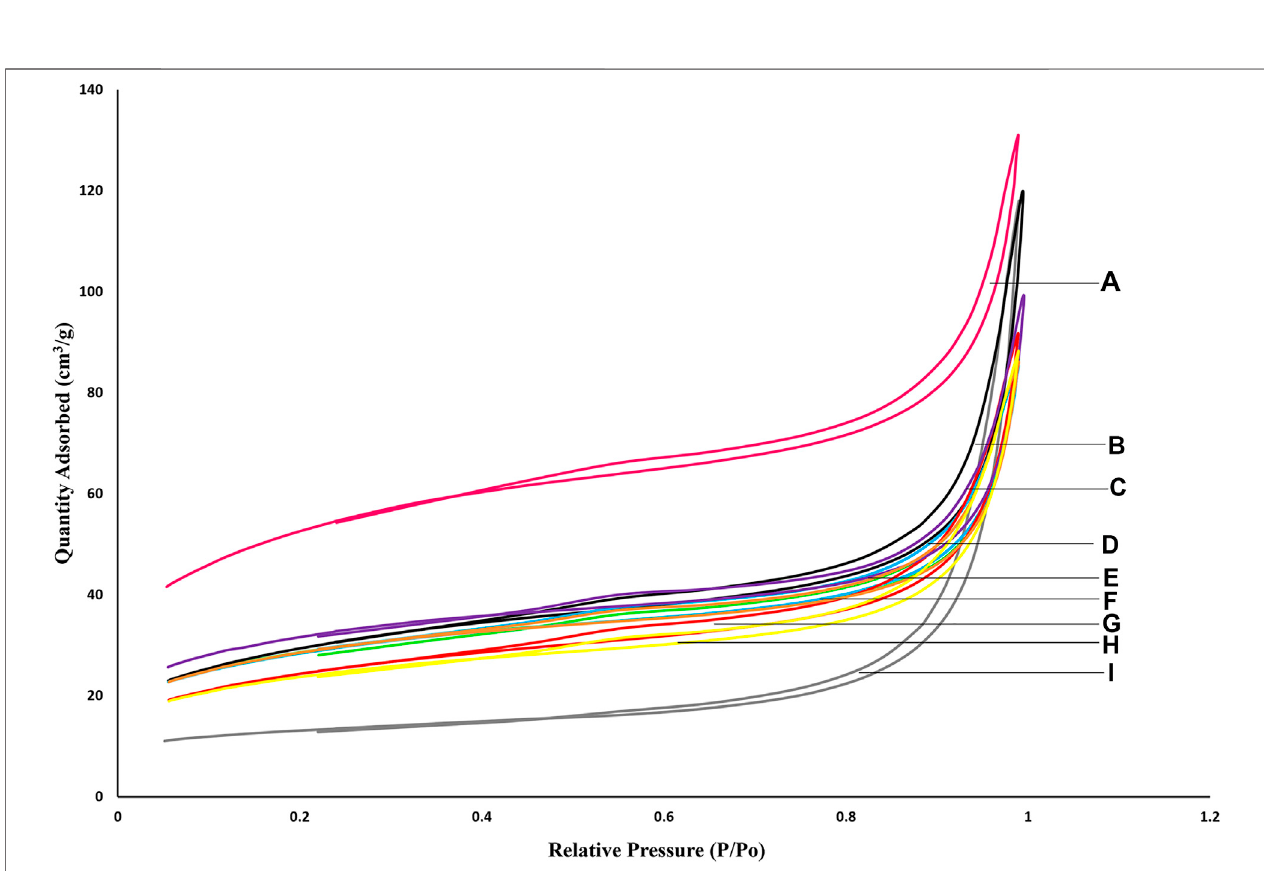
FIGURE1| Adsorption-desorptionisotherms ofOCP f -supported NiMocatalysts (A) Functionalized OCP f (B) 2.5wt%Ni19wt%Mo/OCP f (C) 5.0wt%Ni13wt%Mo/ OCP f (D) 2.5wt%Ni13wt%Mo/OCP f (E) 5.0wt%Ni19wt%Mo/OCP f (F) 3.5wt%Ni13wt%Mo/OCP f (G) 3.5wt%Ni19wt%Mo/OCP f (H) 5.0wt%Ni26wt%Mo/OCP f , (I) Pristine OCP f .